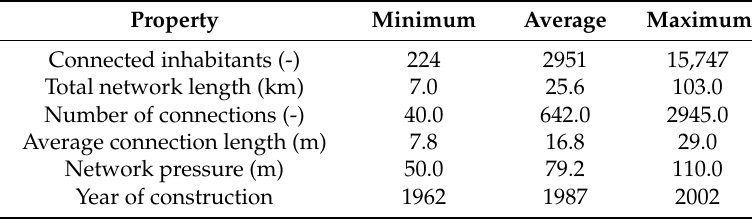
Table 1. Primary characteristics of the 40 investigated water distribution networks